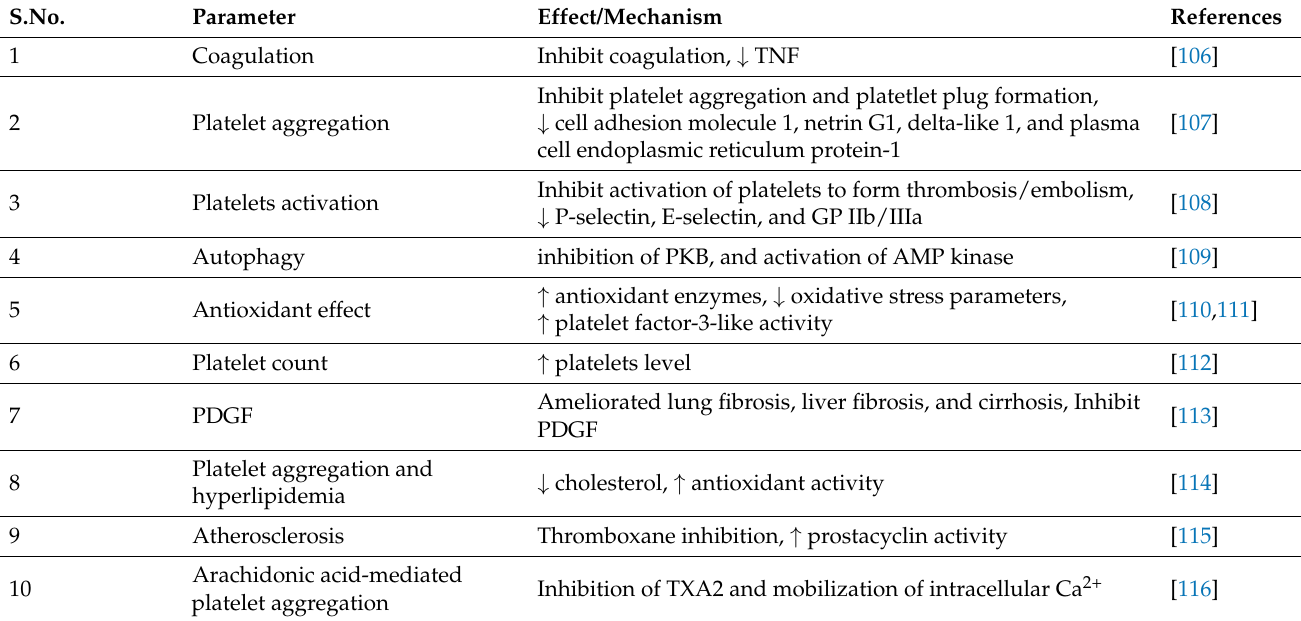
Table 1. Effects of curcumin on